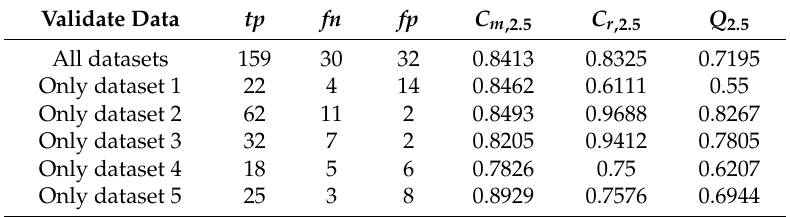
Table 2. Object-based evaluation results on all validation datasets and on individual datasets using the completeness, C m ; correctness, C r ; quality metrics, Q ; ( C m, 2.5 , C r ,2.5 , and Q 2.5 are for buildings over 2.5 m 2 ),